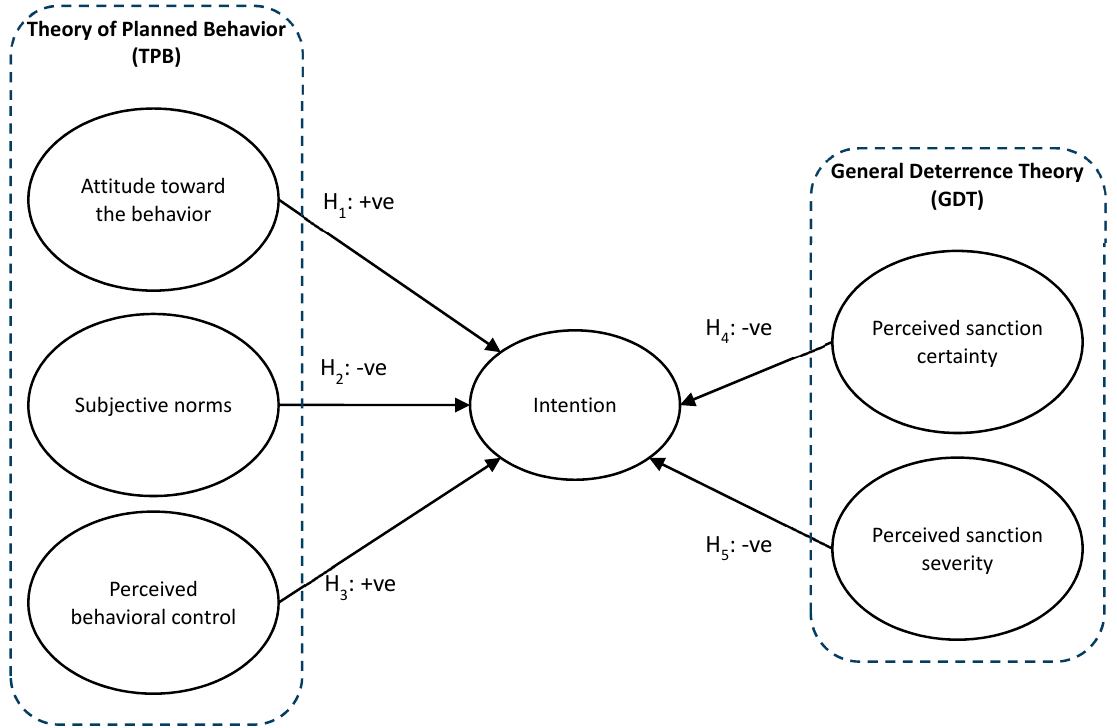
Figure 1. Research model and the hypotheses.